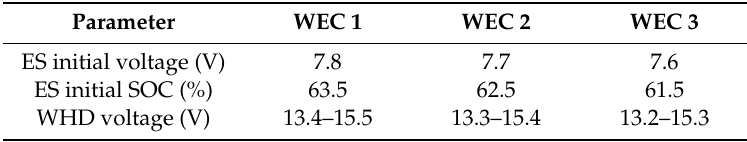
Table 4. Initial parameters of Test